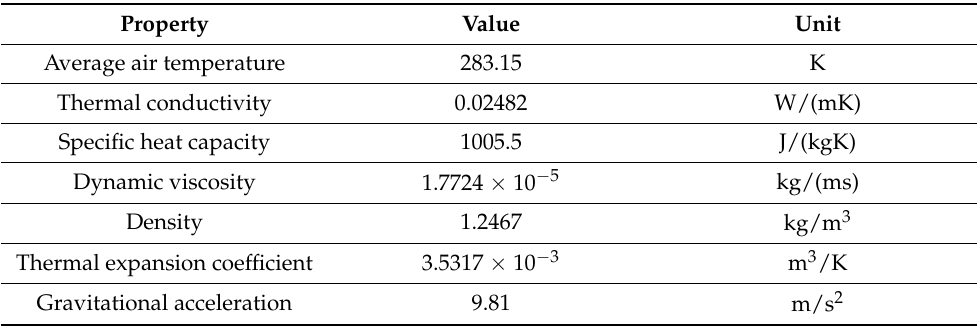
Table 1. Air properties for interior frame cavities used in computational fluid dynamics (CFD)